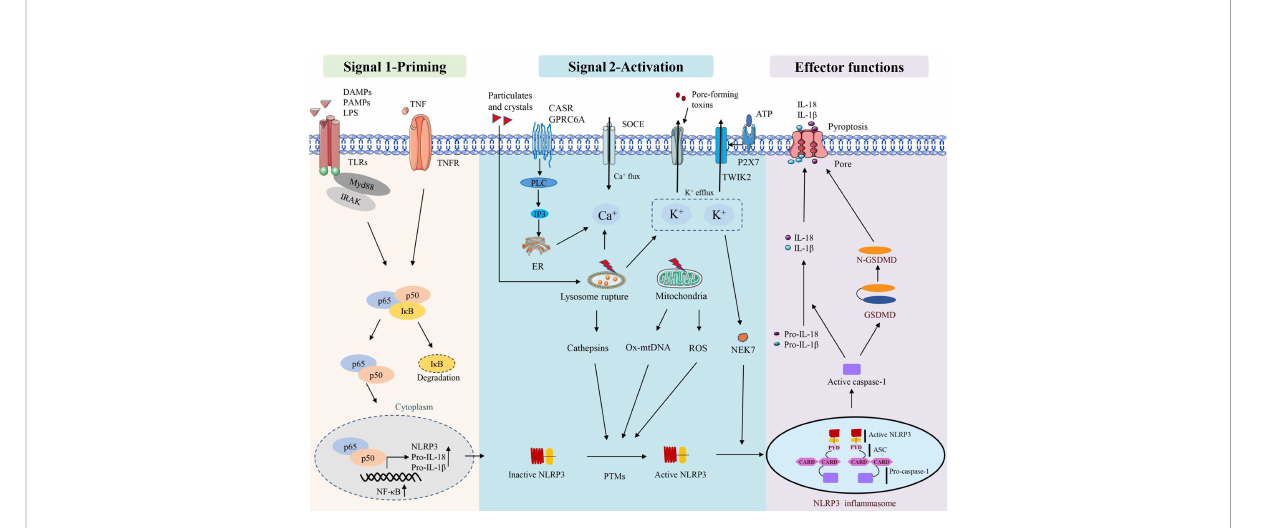
FIGURE 1 Activation and effector functions of the NLRP3 in fl